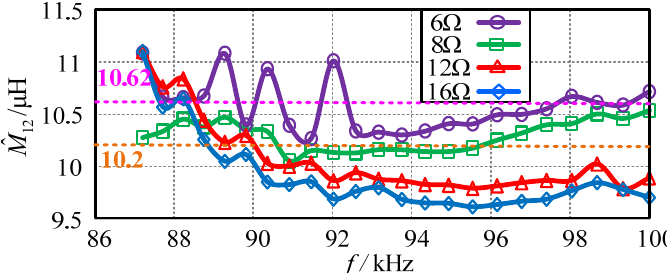
Figure 16. Online mutual inductance estimation results at different loads.